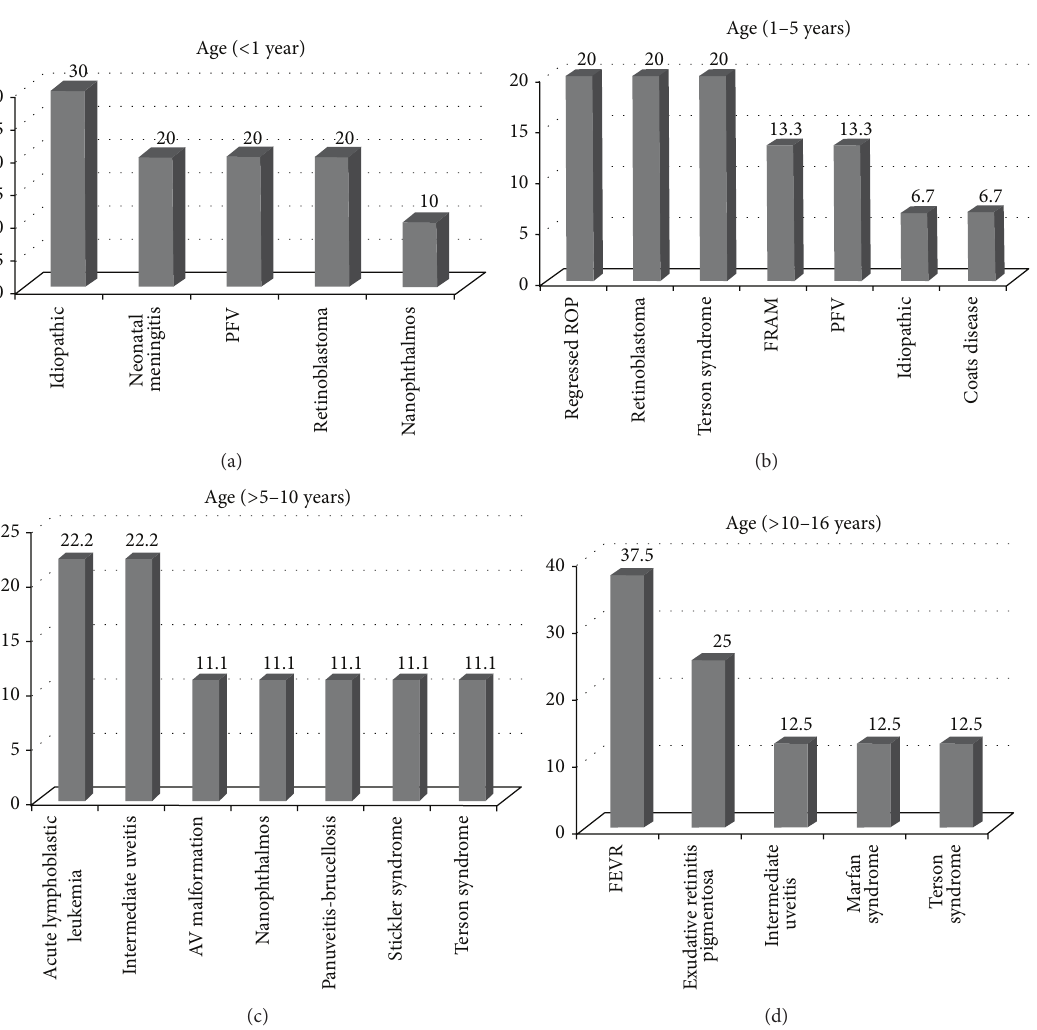
Figure 1: Causes of nontraumatic vitreous hemorrhage according to age group. (a) PFV: persistent fetal vasculature. (b) ROP: retinopathy of prematurity. FRAM: familial retinal artery macroaneurysm. PFV: persistent fetal vasculature. (c) AV: arteriovenous. (d) FEVR: familial exudative vitreoretinopathy.